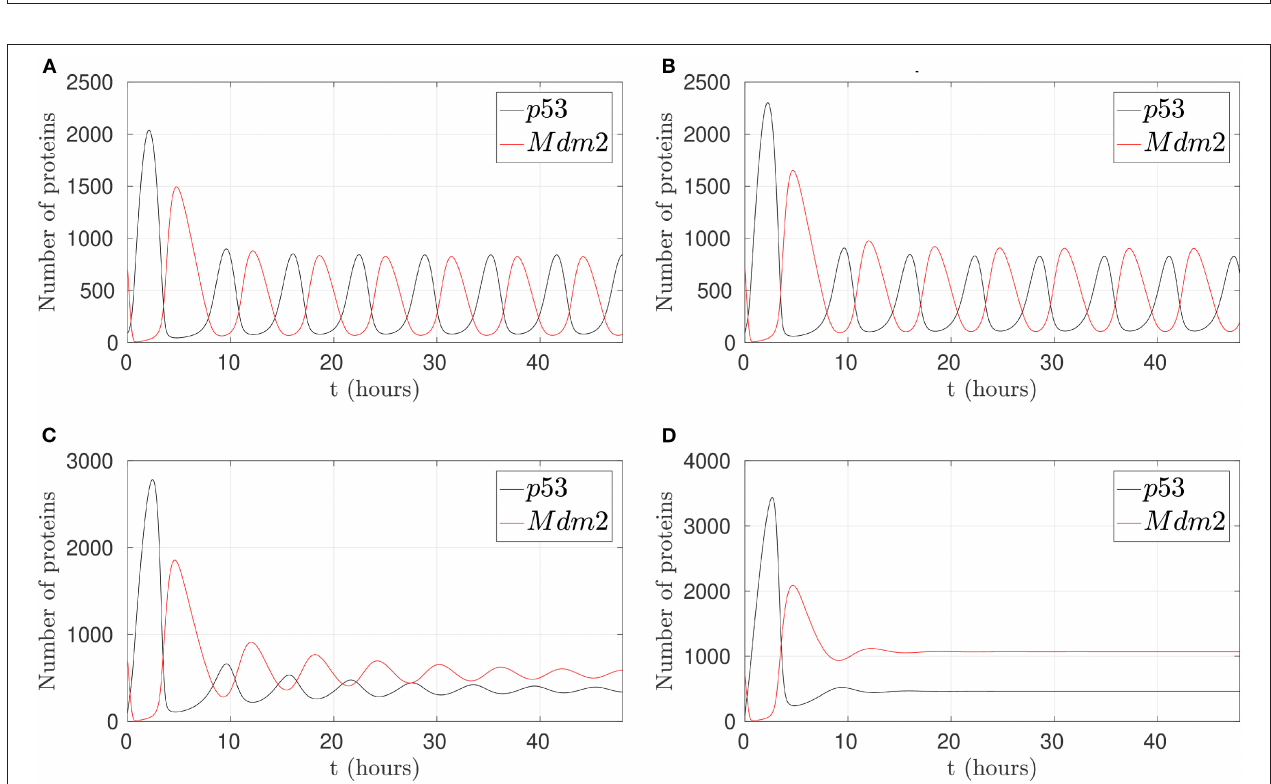
FIGURE 4 | Behaviors of the p53-Mdm2 network regulated by p14ARF under Nutlin-3 effect. (A) With 25% activity in k1. (B) With 50% activity in k1. (C) With 75% activity in k1. (D) With 90% activity in k1. (C,D) Shows desynchronized p53-Mdm2 interaction.